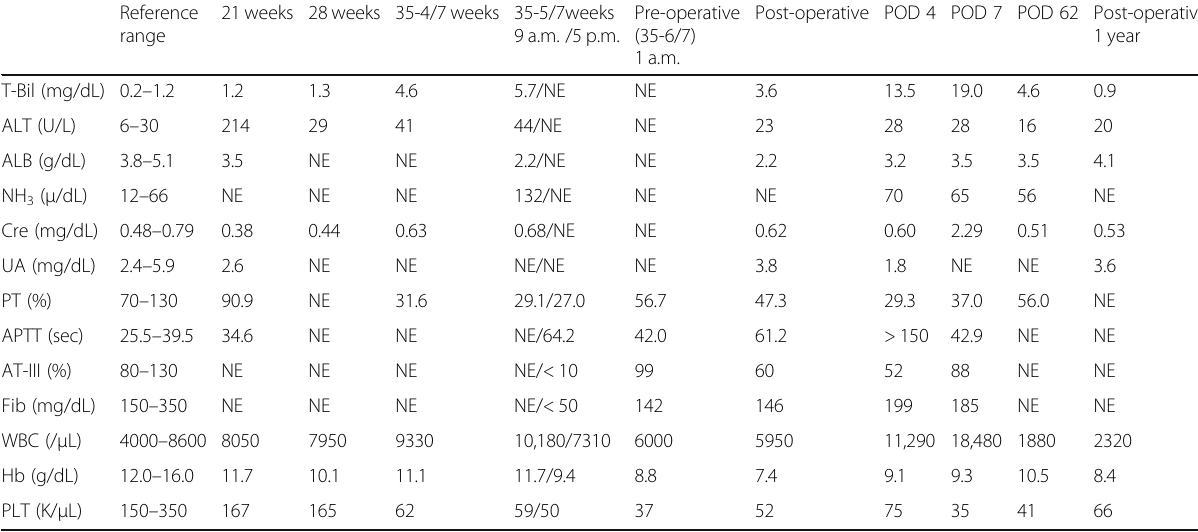
Table 1 Blood sampling data Reference